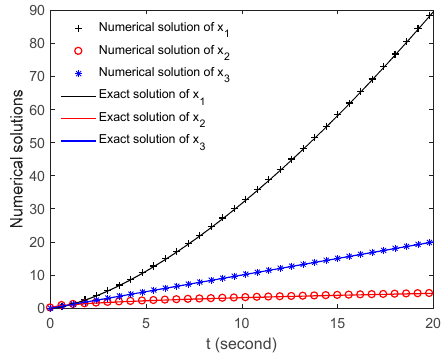
Figure 1. Comparison between the exact solutions and the numerical solutions obtained by the present mothed.